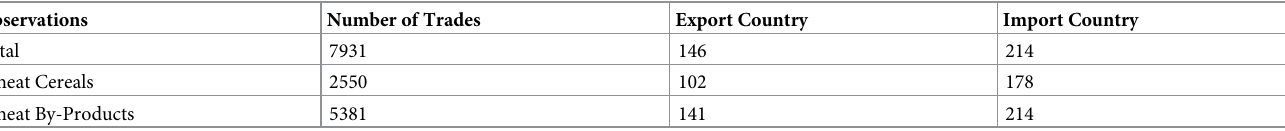
Table 2. Summary descriptive of global wheat supply.